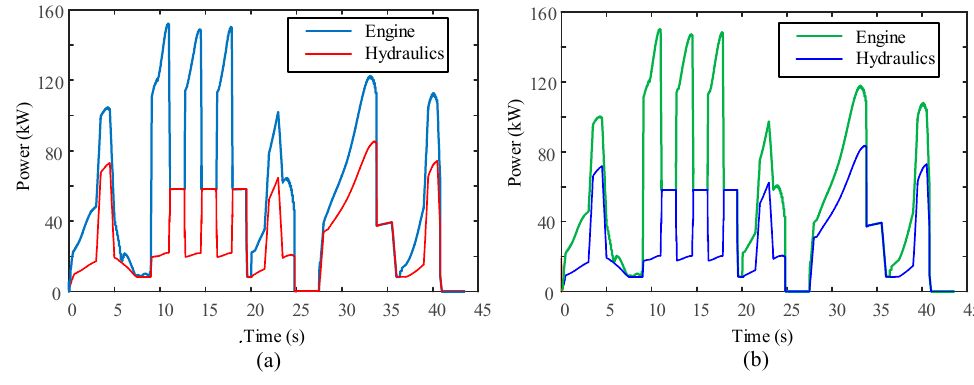
Figure 16. Load power of engine and working hydraulics system. ( a ) Prototype TC; ( b ) Solution c .